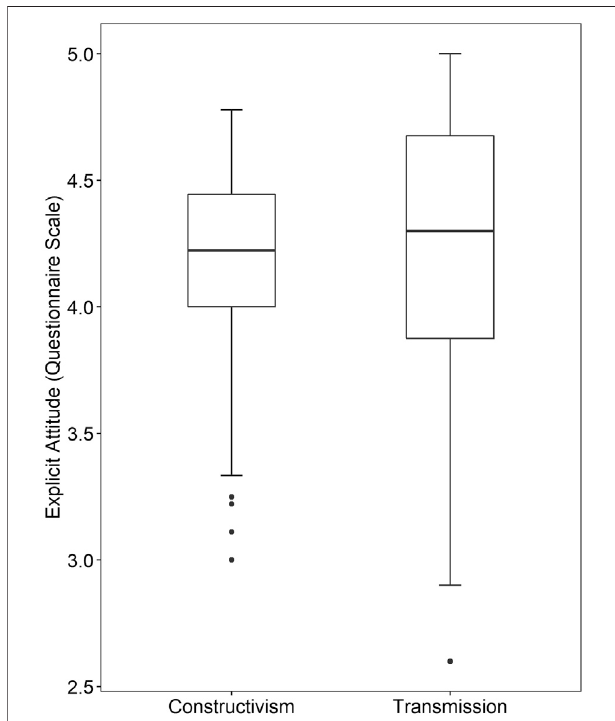
FIGURE 3 | Explicit constructivist and transmissive attitudes of all participants at T 1 ( N (cid:1) 100).